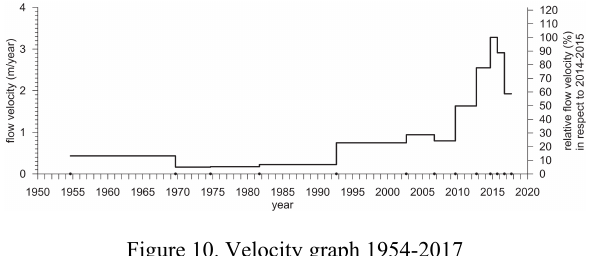
Figure 10. Velocity graph 1954-2017